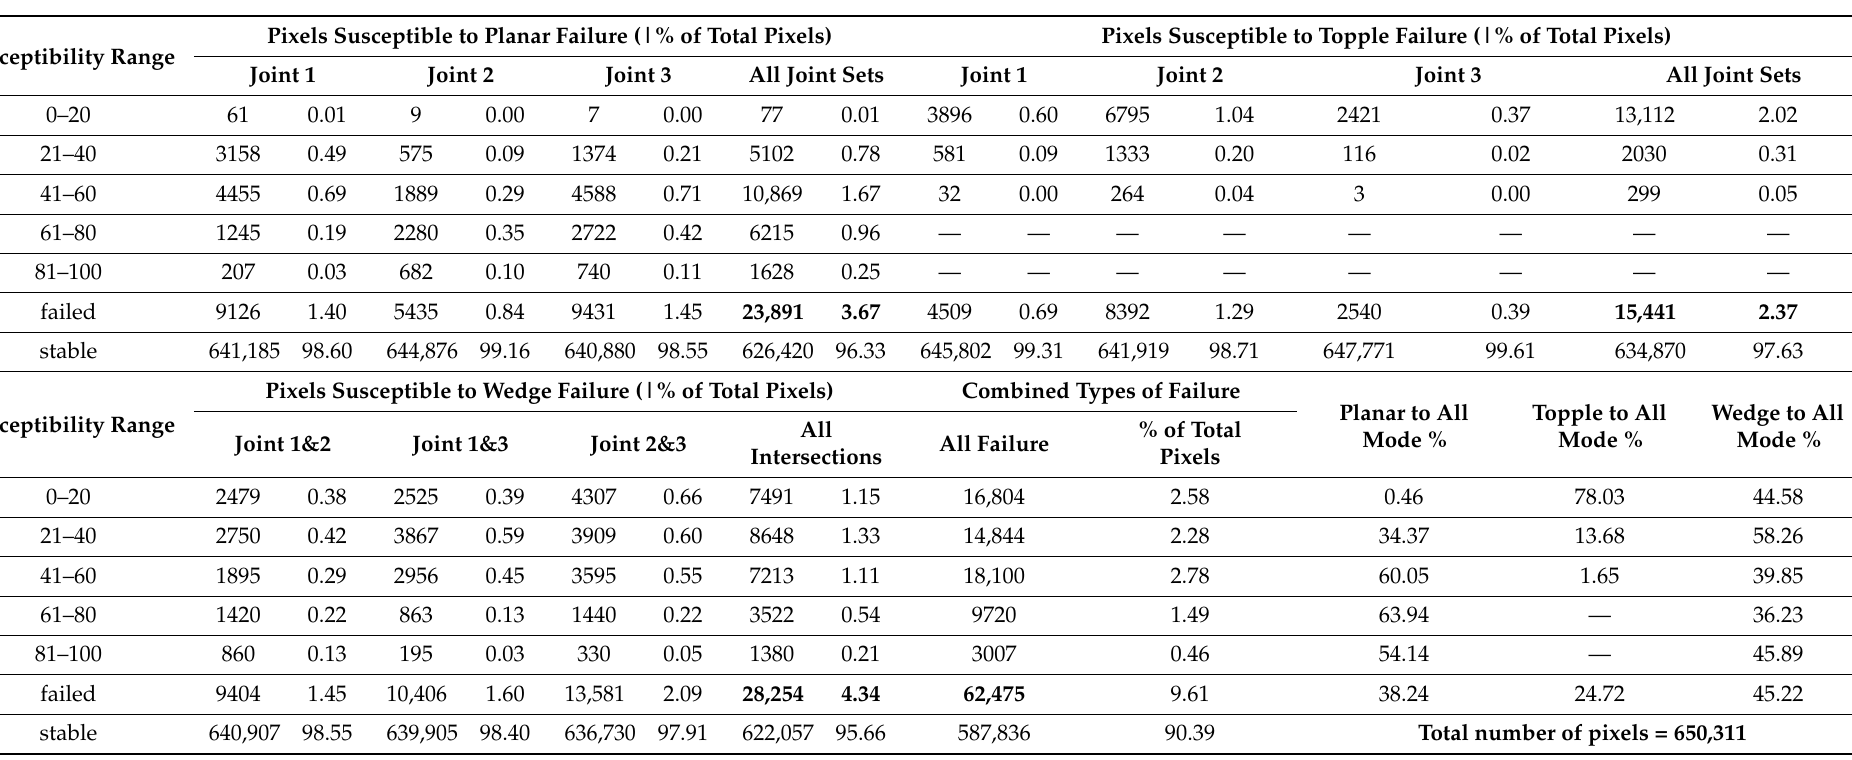
Table A2. Quantitative information on the number of pixels susceptible for each mode and all types of failure separately & combined for all sets of